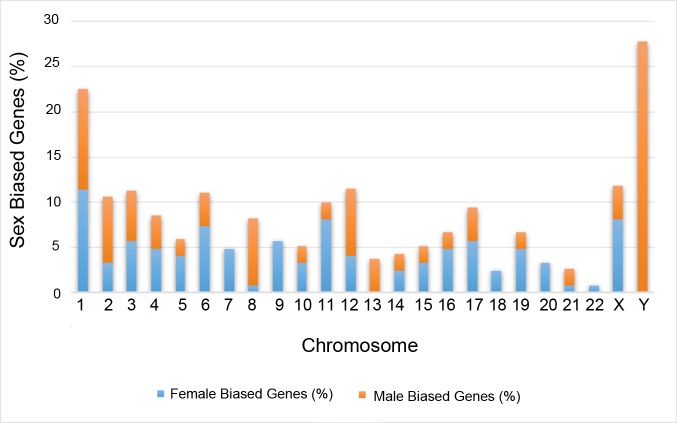
Chromosomal enrichment.For each chromosome, the number of male- and female-biased genes was computed, the table below the graph lists chromosomes that passed the test for enrichment by Fisher exact test with Benjamini correction, P < 0.05.